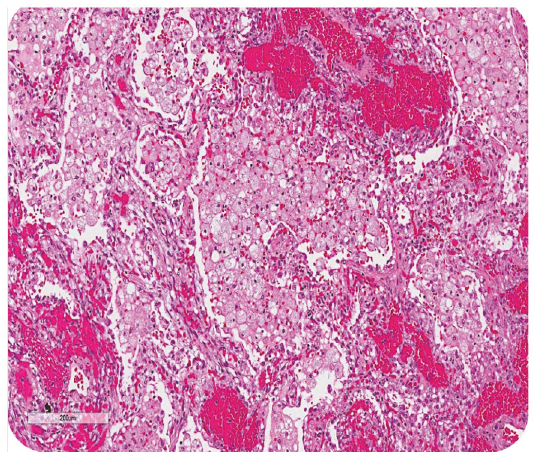
Figure 5: Histopathology of the bronchial cast shows fibrin (black arrow) with few leukocytes (white arrow).